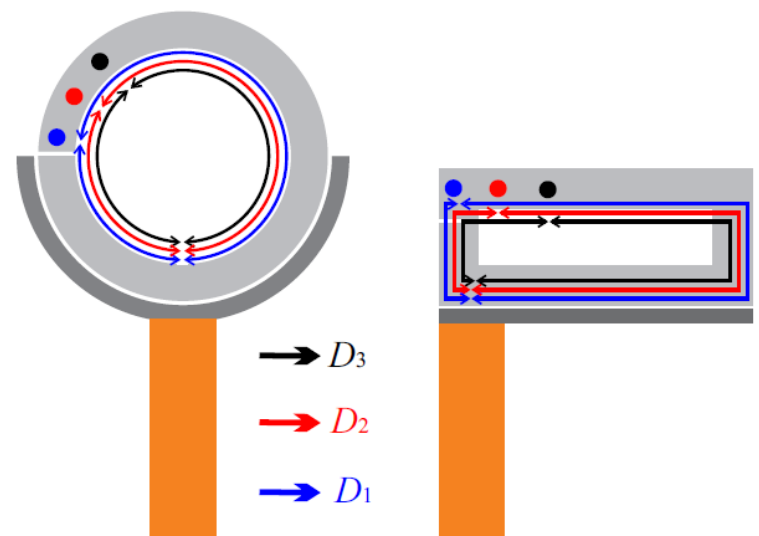
Figure 1. Top view of sensor layouts for circular and rectangular resonators. Orange microstrips are the feeding lines, grey lines are the external coupling lines, and light-grey lines are the resonant structures. Dots display short locations for sensors configuration D 1 , D 2 , and D 3 . Colored arrow-lines are just illustrative to show the difference in distances seen by the traveling waves.